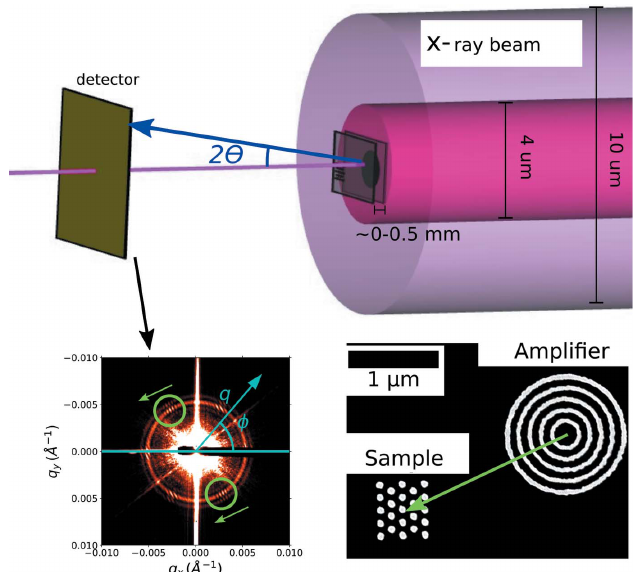
Figure 1 Experimental setup. The amplifier (ring structure) is placed upstream of the sample of interest. The X-ray beam is denoted by the large purple cylinder; the inner cylinder denotes the approximate transverse coherence length (the longitudinal coherence length is large). When the sample and amplifier are within the same coherence volume, the scattering pattern (lower left) exhibits fringes (circled in green) whose spacing and direction are related to the transverse separation between the two scattering entities (green arrow). The lower-right figure shows an SEM image of a validation structure, where the sample and amplifier were patterned on a single